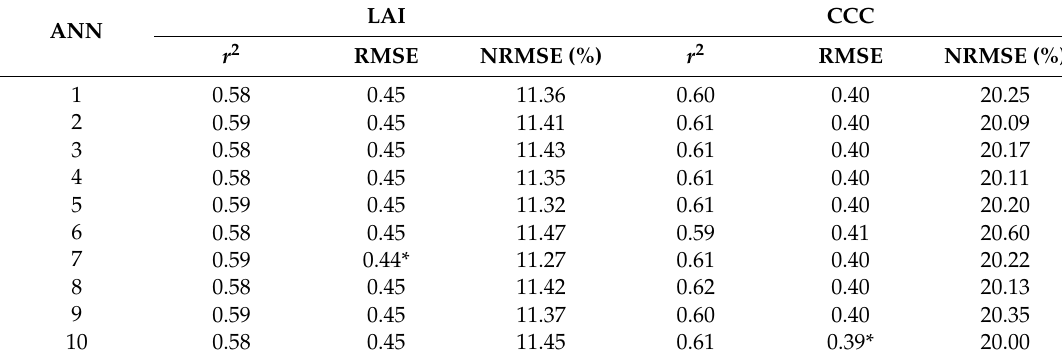
Table A1. Theoretical performance of all trained ANNs (assessed using the testing subset of INFORM simulations). The best performing ANNs, indicated by the lowest RMSE, are marked with